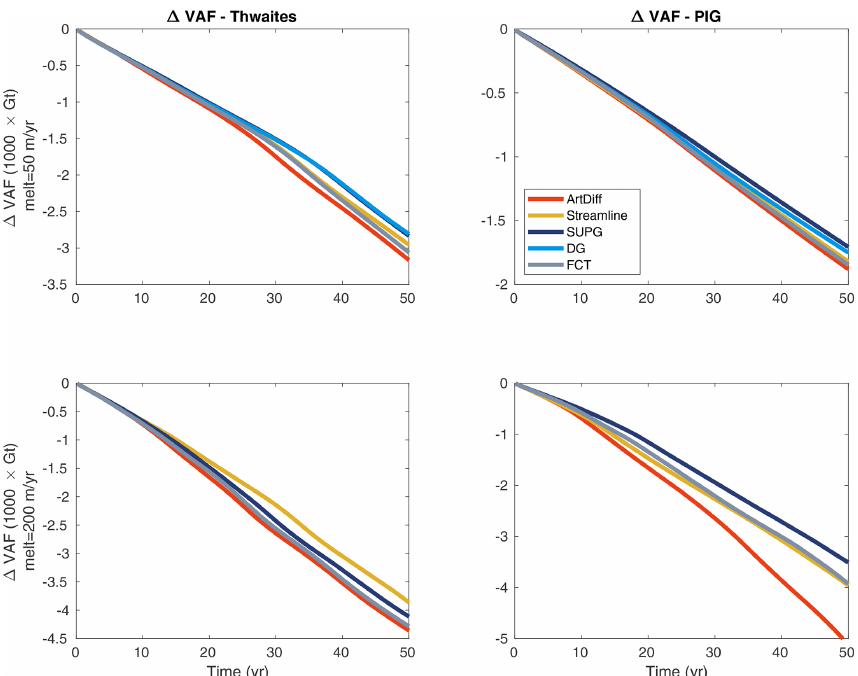
Figure 16. (cid:49) VAF along transient simulations for Thwaites (left panels) and Pine Island (PIG, right panels) glaciers. The transient simulations are forced by two different basal melt rate scenarios: 50myr − 1 (upper panels) and 200myr − 1 (lower panels). The basal melt is applied only on fully floating elements, and the parameterization schemes for basal friction and driving stress are SEP1 and NSED, respectively.